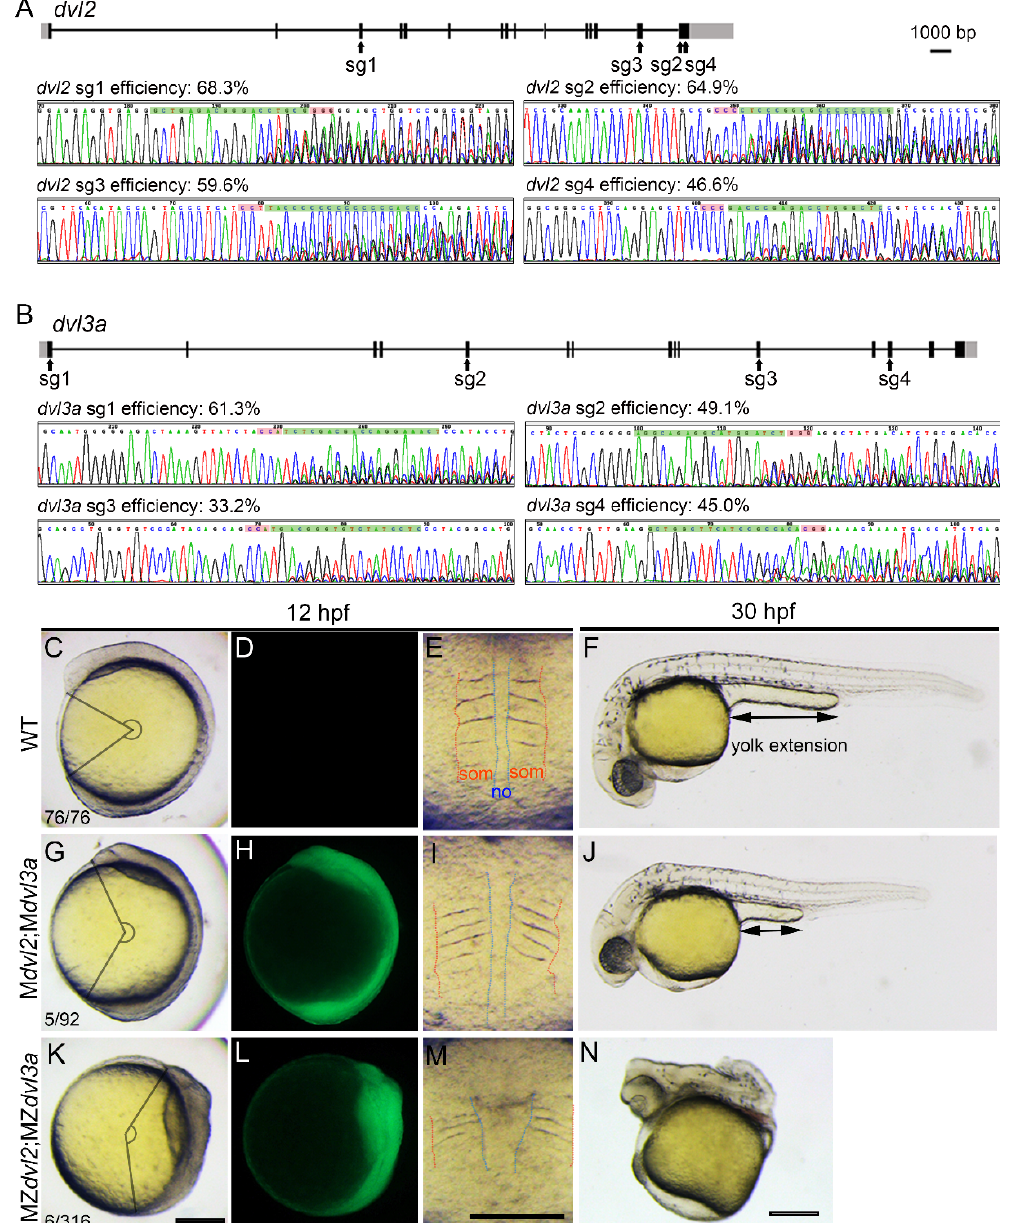
Figure 2. Generation of double maternal mutants of dvl2 and dvl3a by oocyte-specific expression of eight Cas9 RNPs. ( A ) Gene structures of dvl2 , with sgRNA targeting sites (sg1–4) as indicated. Black boxes represent exons, and grey boxes indicate untranslated regions. The chromatograms show indel mutations caused by each sgRNA with estimated mutation rates indicated on the top. ( B ) Positions of the four effective dvl3a sgRNAs and their editing efficacy after coinjection with cas9 mRNAs. ( C ) A 12 hpf wild-type embryo. The central angle is defined by the rostral and rear end of the body axis. ( D ) No GFP expression in the wild-type (WT) embryo. ( E ) Dorsal structures of a wild-type embryo, with red lines showing the outer boundary of somites (som). Blue lines depict the shape of the notochord (no). ( F ) A wild-type embryo at 30 hpf. The bi-directional arrow indicates the length of the yolk extension. ( G , H ) A 12 hpf M dvl2 ;M dvl3a embryo with apparent axis extension defect and GFP expression. ( I ) Mediolaterally wide and anteroposteriorly compacted somites of the embryo as in ( G ). ( J ) The same double maternal mutant at 30 hpf shows a significantly shortened body length and yolk extension. ( K , L ) A GFP-positive MZdvl2;MZdvl3a embryo with severely affected convergence and extension movements at 12 hpf; ( M ) extremely wide notochord and compacted somites of the embryo as in ( J ); ( N ) truncated posterior body and fused eyes of the MZ dvl2 ;MZ dvl3a embryo at 30 hpf. Lateral views with dorsal on the right and anterior up ( C , D , G , H , K , L ) or dorsal up and anterior to the left ( F , J , N ). Scale bars: 200 µ